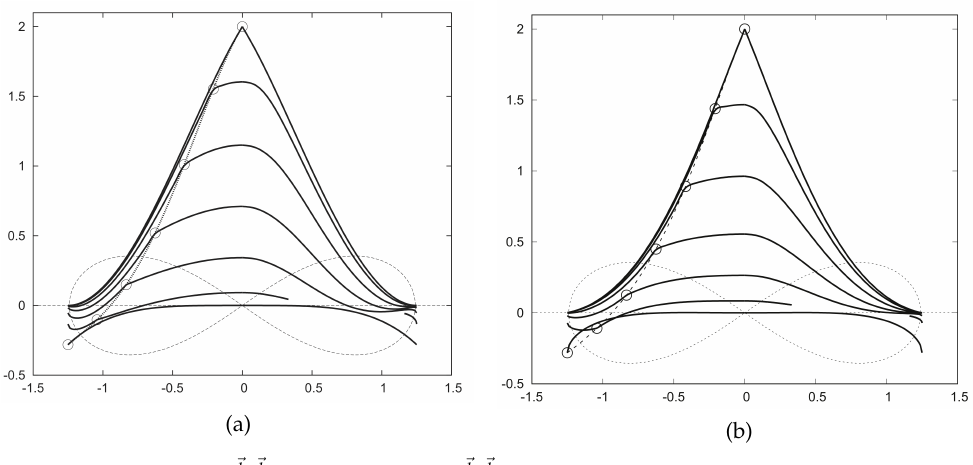
(cid:126) k (cid:126) k 2 , 3 in panel ( b ) depending on P 2 at fixed P . Each (cid:126) k , (cid:126) k 1